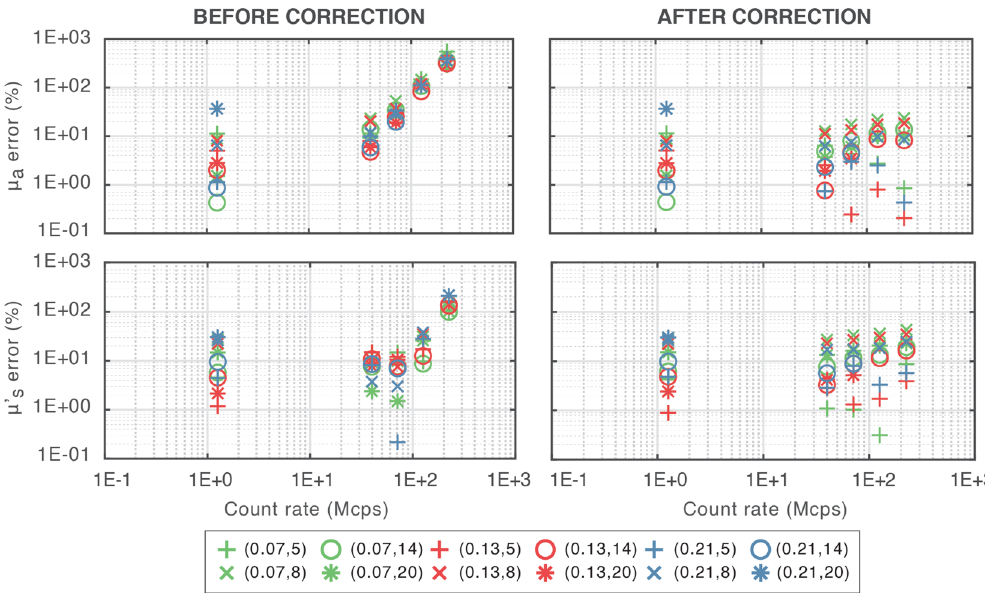
Figure 2. MEDPHOT protocol results for experimental data. Each single point represents the absolute error for a particular phantom. Marker colors refer to different absorption coefficients, while marker types to different scattering ones. Absorption (first row) and reduced scattering coefficients (second row) errors are represented at various CRs, for all the phantoms. In all cases, both results before (left plots) and after (right plots) correction are